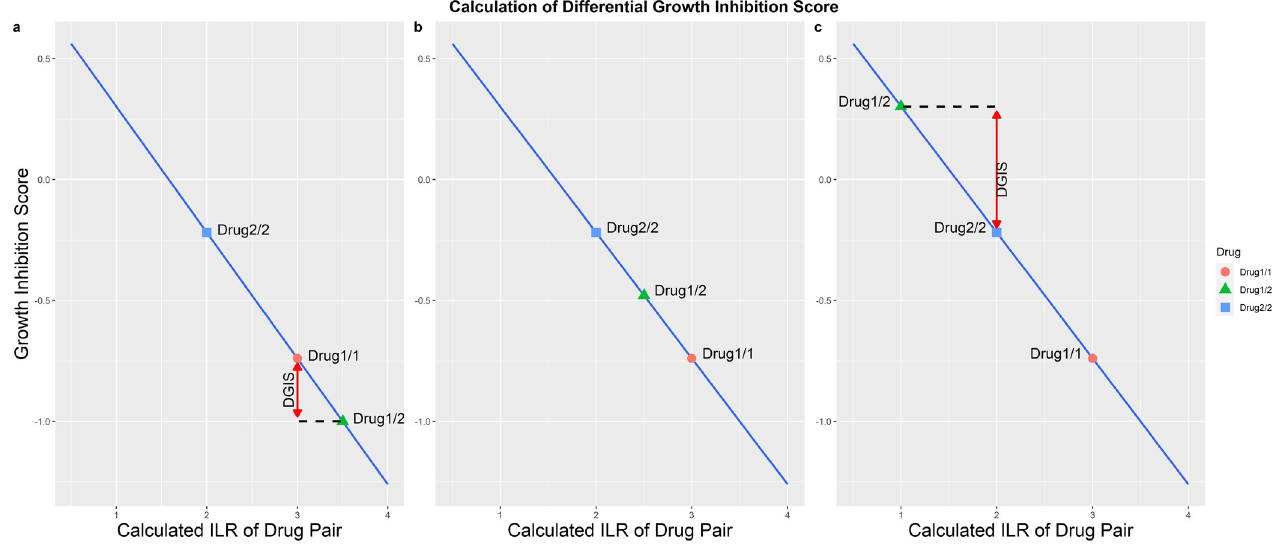
Fig 3. Schematic diagram of how to calculate the